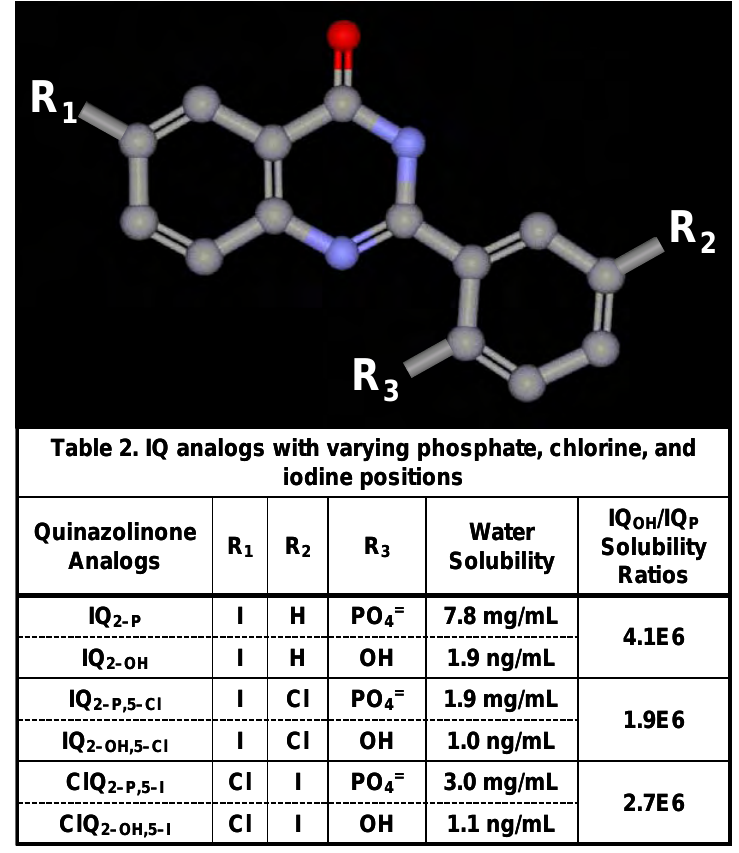
Figure 3. Structure and water solubility of iodinated quinazolinone derivatives.